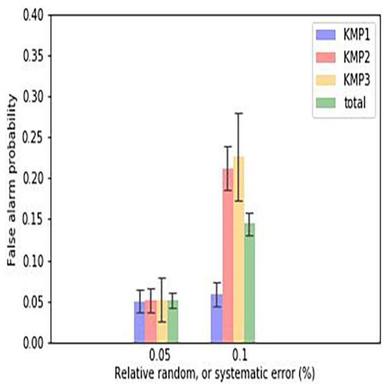
3. By modifying the relative measurement errors and using the exact same numerical value for the alarm threshold for every KMPs, the false alarm probabilities can vary. contains the detailed numerical output.